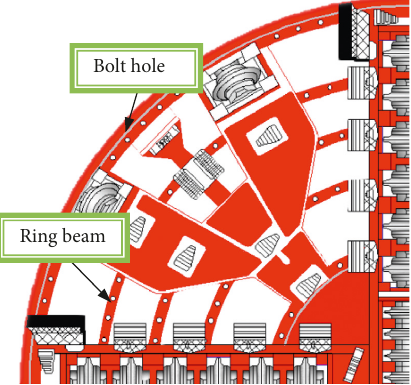
Figure 7: Layout of the bolt